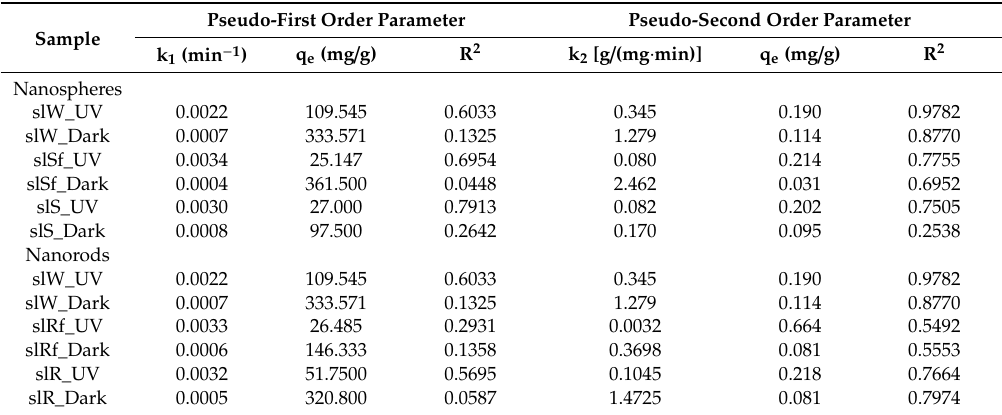
Table 4. Parameters of kinetics models for the adsorption of MB on metallurgical slag-based alkaline cement with and without ZnO nanoparticles.